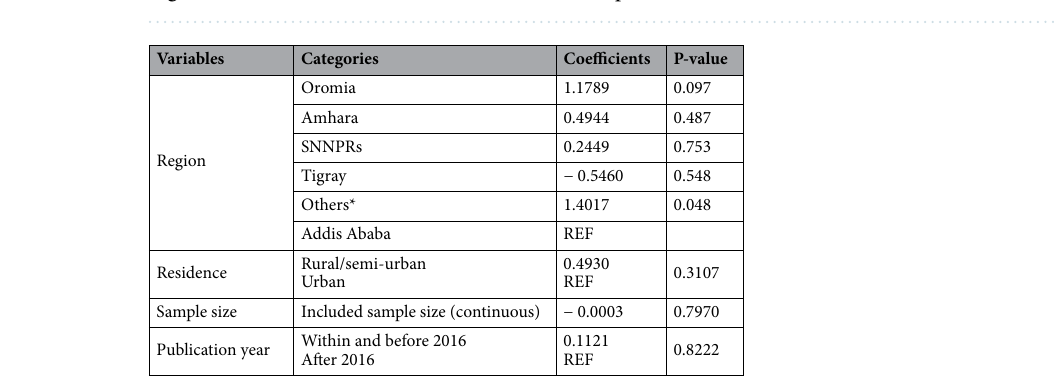
Table 3. univariate meta-regression analysis result for prevalence of food taboo practices among pregnant women in Ethiopia. Others* = Somali, Benishangul gumuz, Gambela and Afar; REF = reference